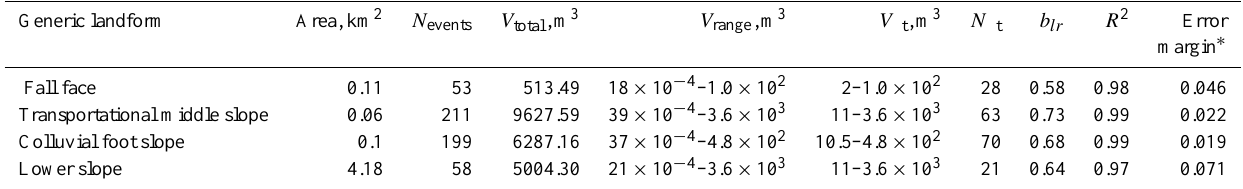
Table 3. Characteristic of rockfall volume distribution in Gunung Kelir. Generic landform